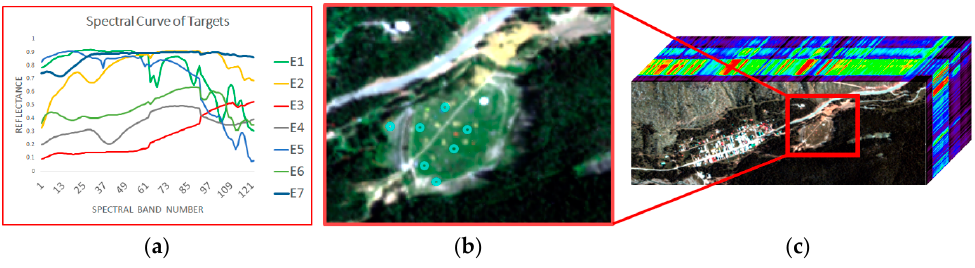
Figure 6. Implanted RIT dataset: ( a ) the spectral curve of implanted targets; ( b ) the location of implanted targets in selected subset; and, ( c ) the original data.